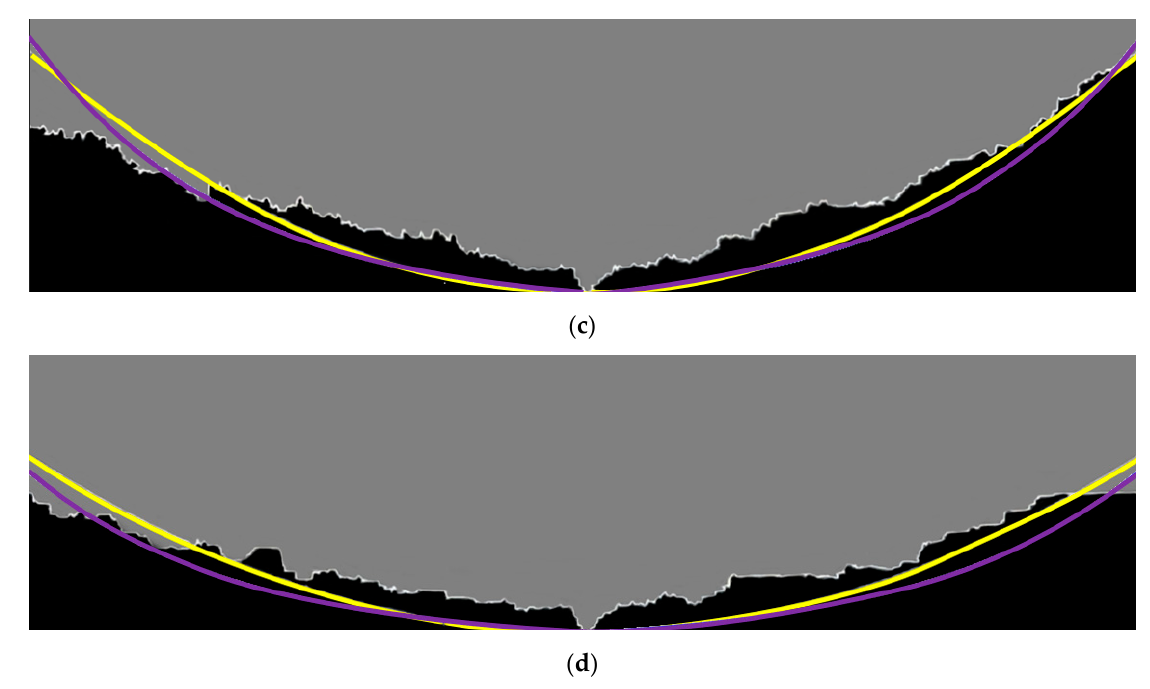
Figure 16. Comparison of the solvent chambers estimated by exponential model, solvent chambers estimated by parabolic model [3], and experimentally visualized [3] solvent chambers in test #1 at